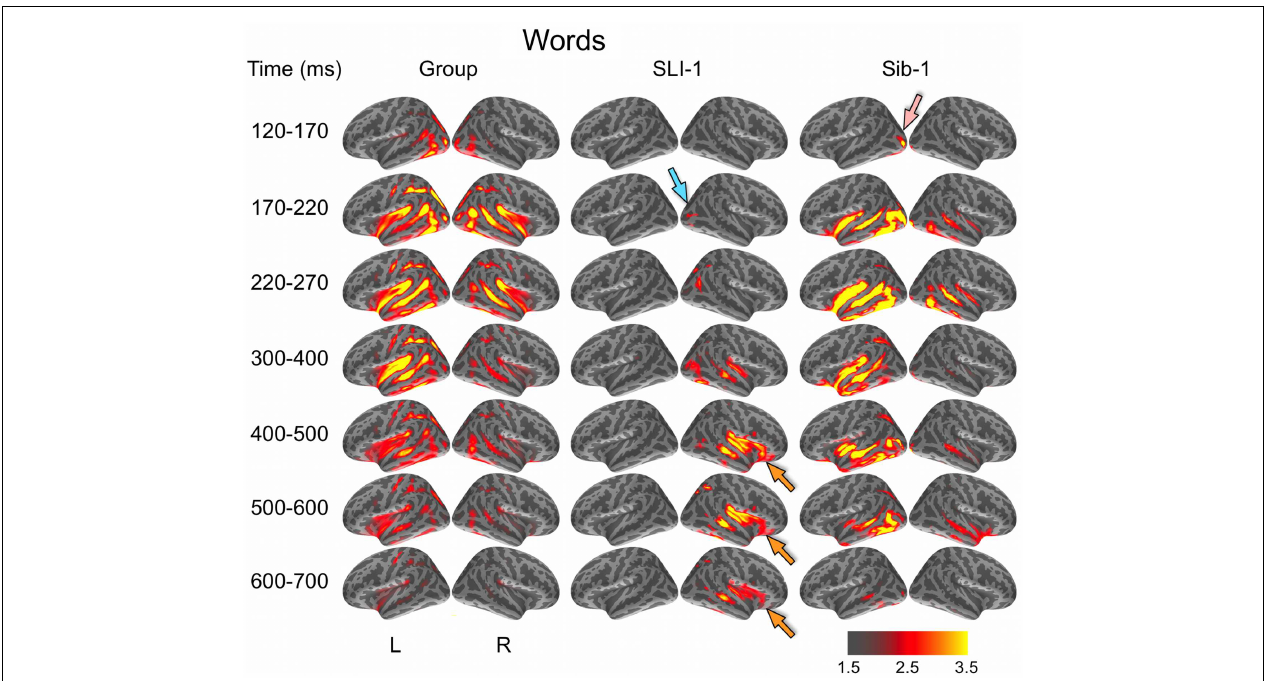
delayed in time (blue arrow) in relation to his sister (pink arrow). During latencies typically associated with semantic encoding, he showed sustained activity within right temporal, perisylvian, and frontal opercular regions (orange arrows). Color scale represents square root of F values, which are a measure of